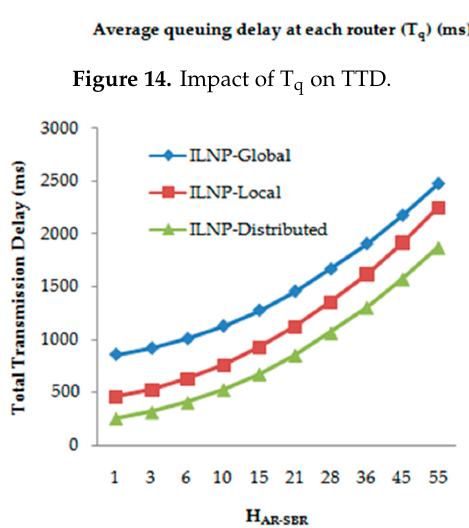
Figure 15. Impact of H AR-SBR on TTD.